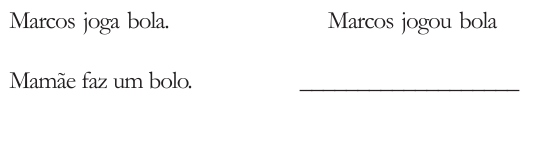
Figura 6. Exemplo de item da tarefa de analogia de sentença.